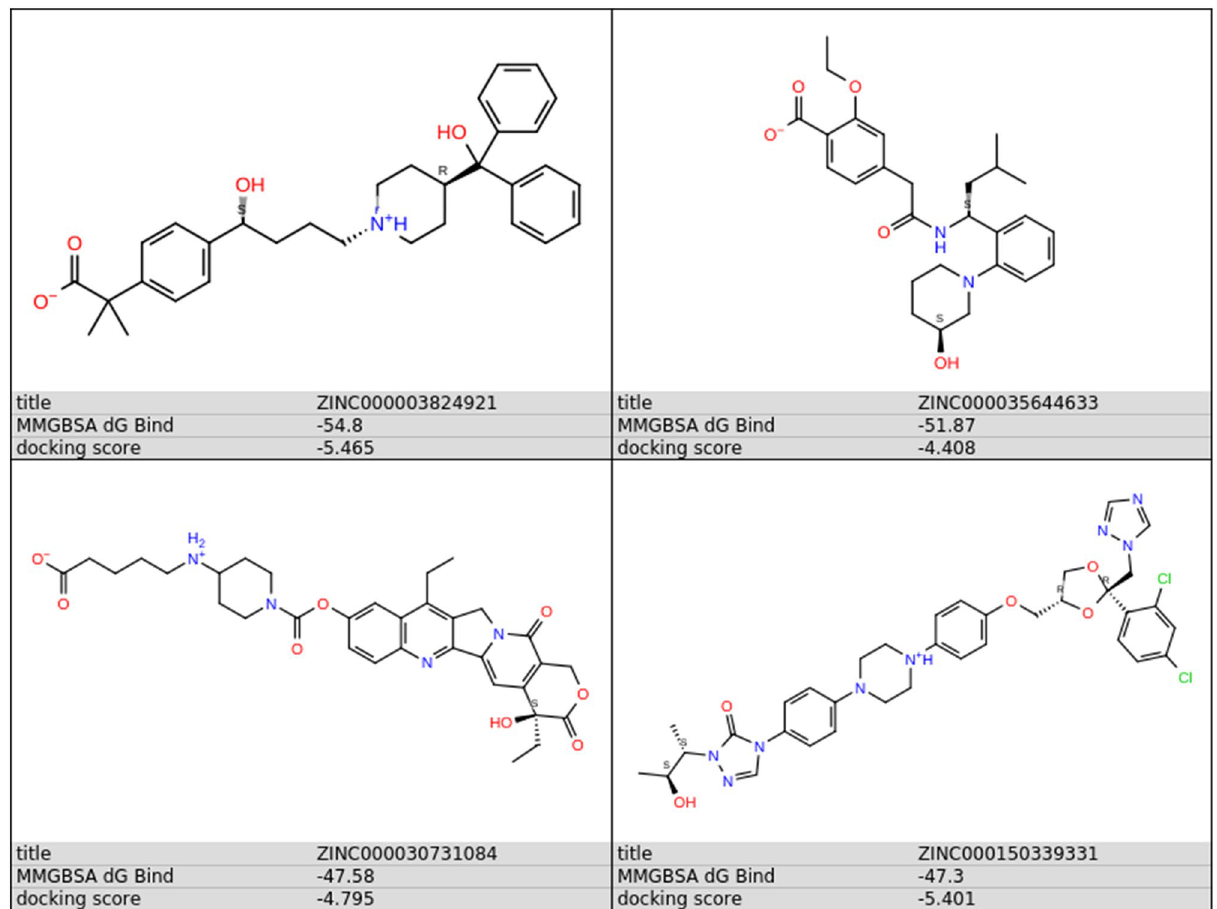
Figure 5. The chemical structures of the compounds remaining bound to the predicted binding pocket in the MD Compounds #4, #15 and #17 are very stable within the predicted binding site for the total simulation time. Compound #2 remained bound to the binding pocket, but while its hydroxy(diphenyl)methyl moiety (Fig. 5) forms stable hydrophobic and hydrogen bonds interactions with Tyr505 and Gln493, respectively, all over the simulation time, the hydrogen bonding interactions of the methylpropionyl group of #2 with Arg452 or Ser494 were broken between 20 and 65 ns (giving rise to the increase of the RMSD lig ) and reformed between 65 and 90 ns (Fig. S1). Superimposition of RMSD and RMSF plots for the stable complexes is shown in Fig. 6. The Cα-RMSD of unbound RBD is also shown for comparison indicating that the protein’s structure did not change during the simulation time (Fig. 6A). The variation of RMSD lig highlighted the considerable stability of the ligand position inside the binding pocket, and the major flexibility of fexofenadine (ZINC000003824921) (Fig. 6B). In addition, the Cα-RMSF was also calculated to monitor structural fluctuations and get further insight about the binding mode analysis of selected ligands. It is important to point out that also the RMSF plots of the complexes were highly similar to that of RBD (Fig. 6C). This was especially remarkable for those residues critically involved in molecular recognition, where least fluctuations were observed (green bars in Fig. 6C). Analysis of trajectories indicated that the selected drugs remained close to their initial positions obtained from docking analysis, confirming the formation of stable complexes. Simulation interactions diagrams during the entire MD run provided insights into the interaction pattern of the four ligands with Delta RBD. Figure 7 shows those interactions occurring during the MD simulation. Ligand #2, #4 and #15 exhibited hydrogen bonding and water bridges with Spike RBD through Gln493 and Ser494 and hydrogen bonding interactions with Tyr453. Hydrophobic interactions of #2, #4, #17 ligands with Tyr505 were also observed. Important hydrophobic interactions were observed for #17 with Phe456, Tyr489 and Tyr505. As it can be seen from Table 3 #17 exerted the most favored MM-GBSA energy (− 74.8 kcal/mol), with almost 18 kcal/mol, 24 kcal/mol and 27 kcal/mol difference comparing to #2 (− 56.4 ± 12.0), #4 (− 50.8 ± 16.7) and #15 (− 46.9 ± 4.6), respectively. The favored binding of hydroxy itraconazole can mainly be attributed to the lipophilic term of the binding energy (ΔG Lipo ) and to the non-polar (ΔG SolvSA ) contribution to the solvation free energy (Table 3).